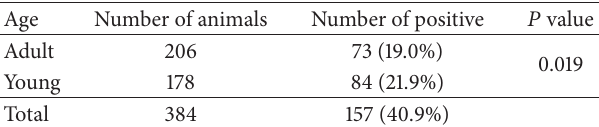
Table2:Prevalenceof Haemonchus insheepbasedontheagegroup.